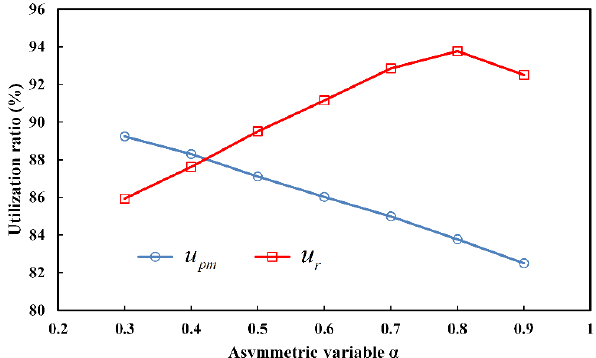
Figure 5. The torque utilization ratios versus the asymmetry coefficient α .